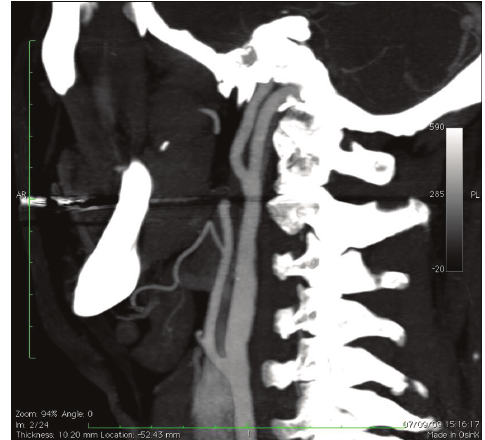
Figure 3: Computed Tomography Angiography (MPR reconstruction): anomalous artery arising from the right internal carotid artery at C2–C3 level, entering the cranium via the hypoglossal canal.